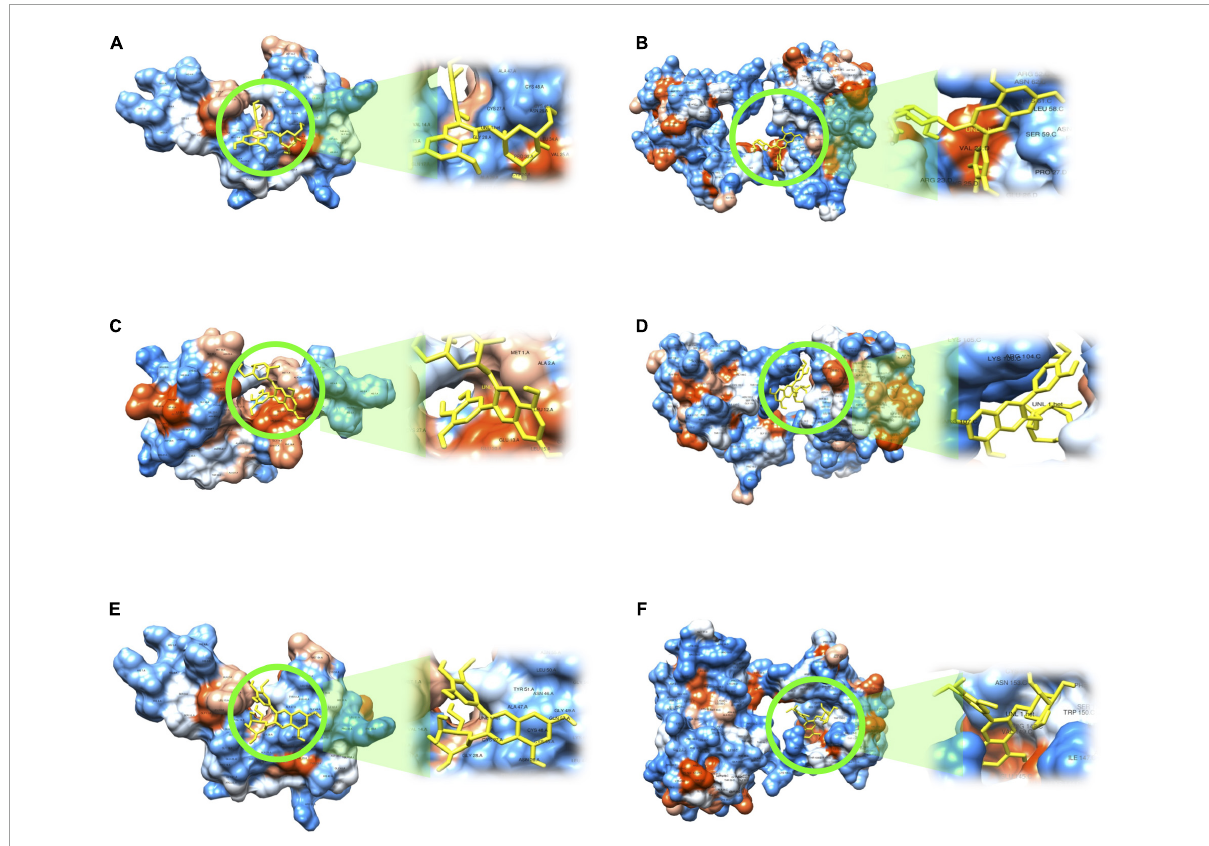
FIGURE6 In silico docking analysis of interactions between main anthocyanins found in black bean extract and potential transcription factors. (A) Delphinidin 3-glucoside to GATA2; (B) Delphinidin 3-glucoside to POU2AF1; (C) Petunidin 3-glucoside to GATA2; (D) Petunidin 3-glucoside to POU2AF1; (E) Malvidin 3-glucoside to GATA2; (F) Malvidin 3-glucoside to